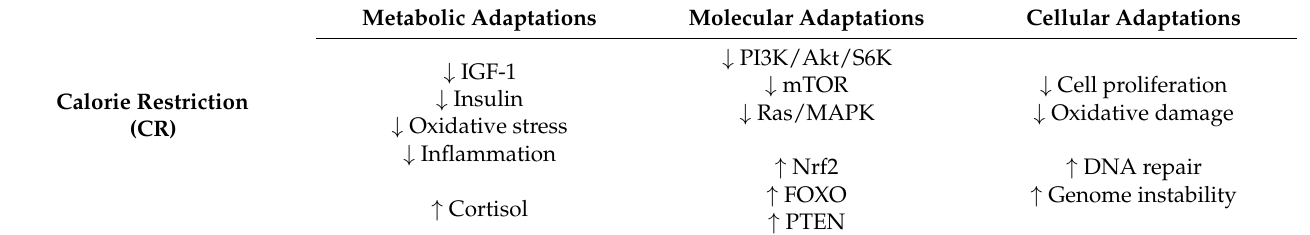
Table 1. Metabolic, molecular and cellular mechanisms induced by CR to prevent cancer. Metabolic